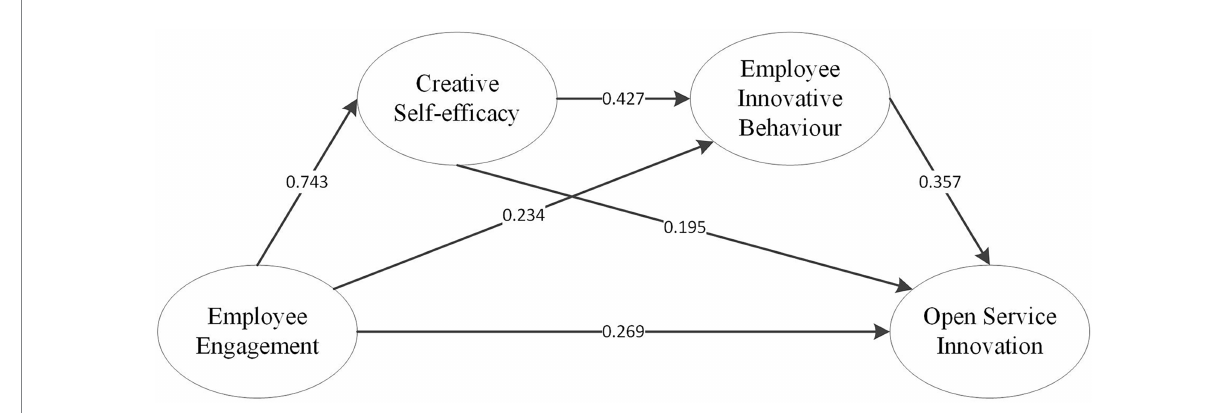
FIGURE 2 Structural equation model of the effect of employee engagement on open service